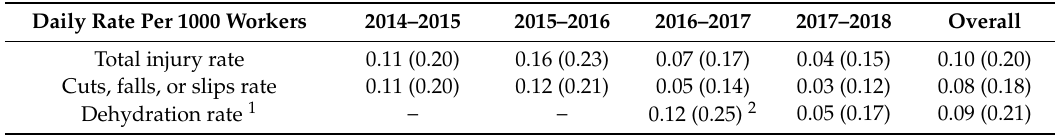
Table 3. Estimated average daily rate of recorded injury and dehydration per 1000 sugarcane harvesters in Southwestern Guatemala, 2014–2018. Presented as mean (SD). Daily Rate Per 1000 Workers